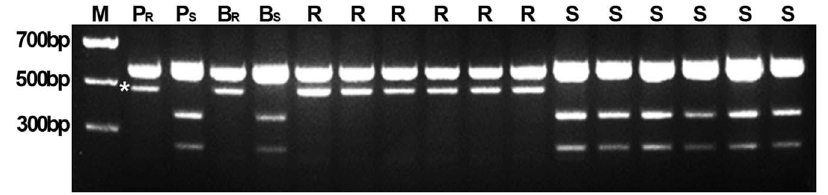
Figure 4. A profile of amplification with marker BQ246670 in F 2 population from cross of CH7086/ Taichung 29. M: DNA ladder; P R : CH7086; P S : Taichung 29; B R : resistant bulk; B S : susceptible bulk; R: homozygous resistant F 2 plants, S: homozygous susceptible F 2 plants. Asterisk indicates the critical band linked with PmCH86